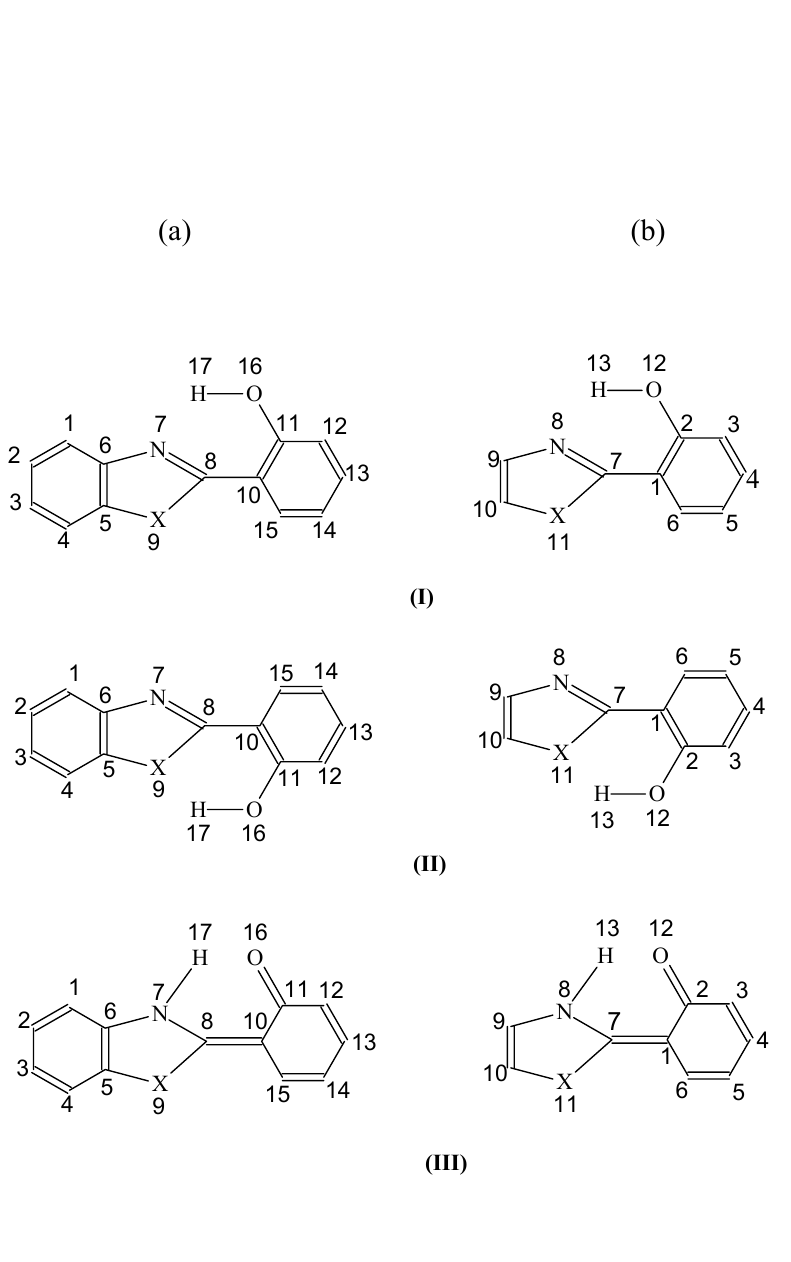
Scheme 1. The normal (I), rotamer (II) and tautomer (III) species of (a) HBO, HBI, HBT and (b) HPO, HPI and HPT. (X = -O-, -NH- and -S- for oxazole, imidazole and thiazole,